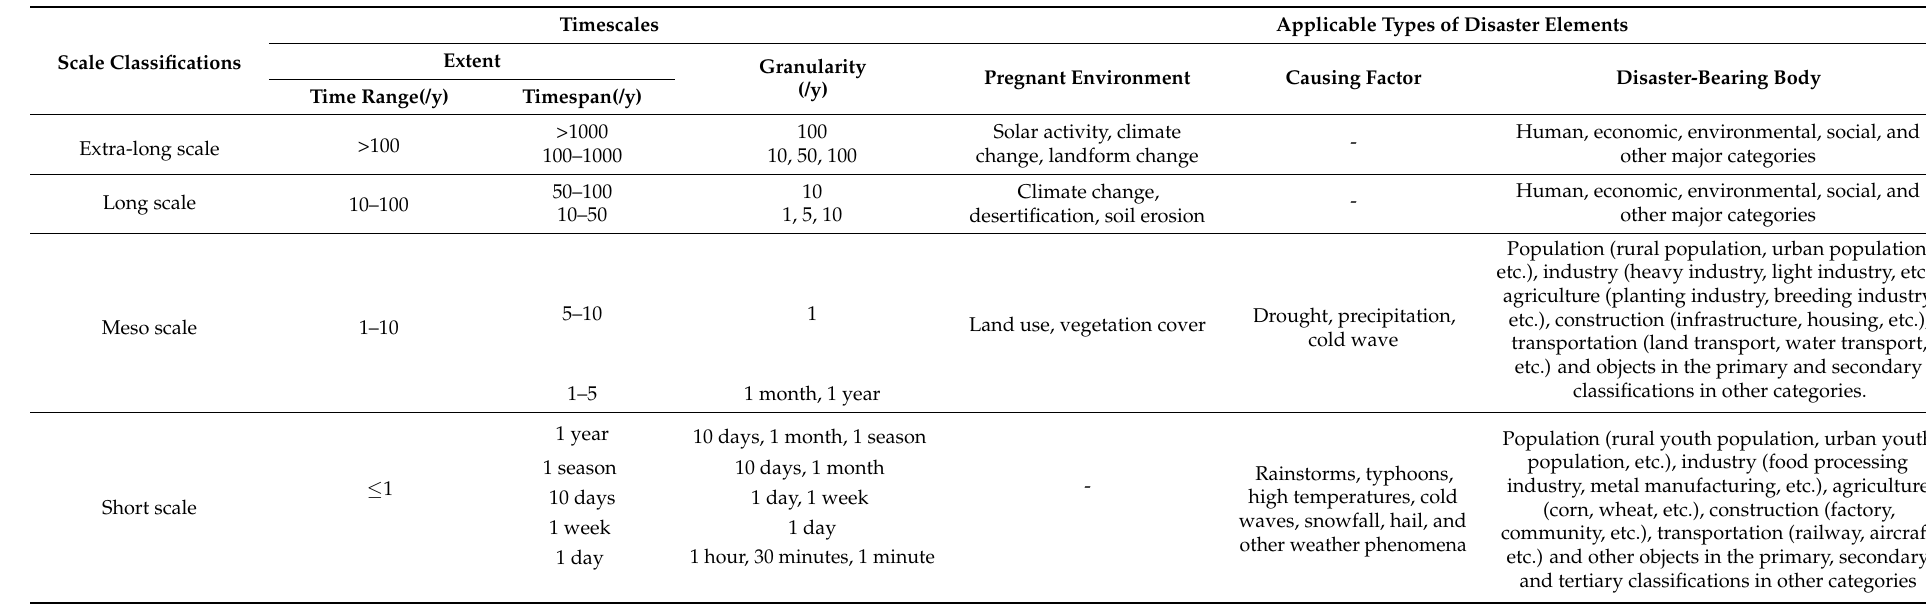
Table 1. Appropriate observation timescale for different meteorological disaster